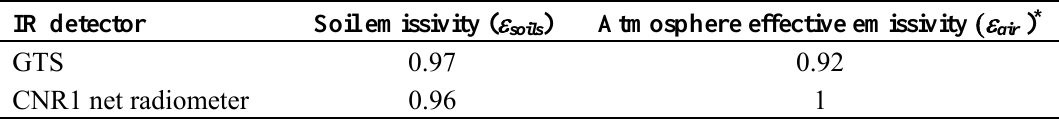
Table 6. Soil and atmosphere effective